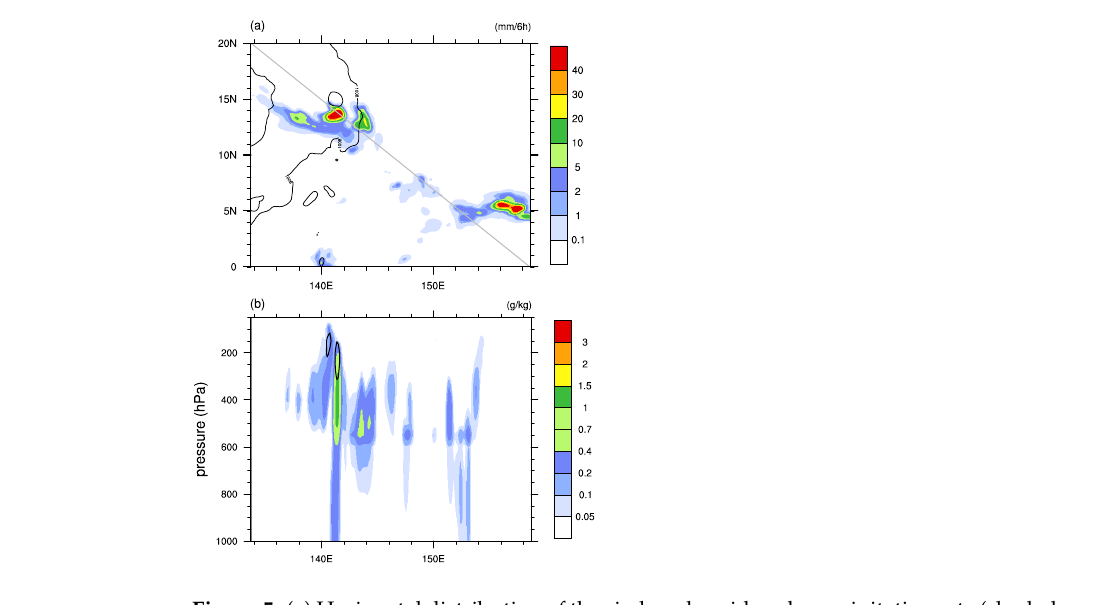
Figure 5. ( a ) Horizontal distribution of the six-hourly grid-scale precipitation rate (shaded; mm 6 h − 1 ) and ( b ) the vertical distribution of the mixing ratio of rain and snow (shaded; g kg − 1 ) across the gray transect in ( a ) at 1200 UTC on 24 July 2017 from the MOD experiment. Sea-level pressure contours (4 hPa interval) are added in ( a ), and contours of vertical velocity of 0.4 m s − 1 are added in ( b ).